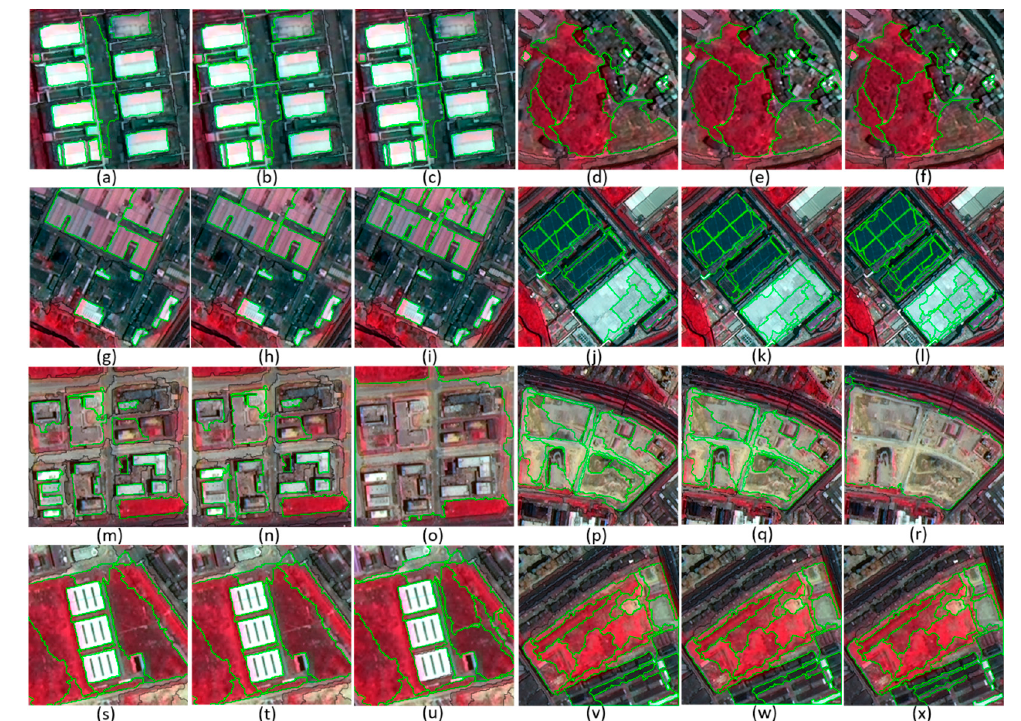
Figure 4. Subsets of the first optimal segmentation results for the four test images: Subsets of ( a – f ) P1, ( g – i ) P2, ( m – r ) P3, and ( s – x ) P4. (the first and fourth columns correspond to the JSM results, the second and fifth columns correspond to the WM results, and the third and sixth columns correspond to the ZM results).